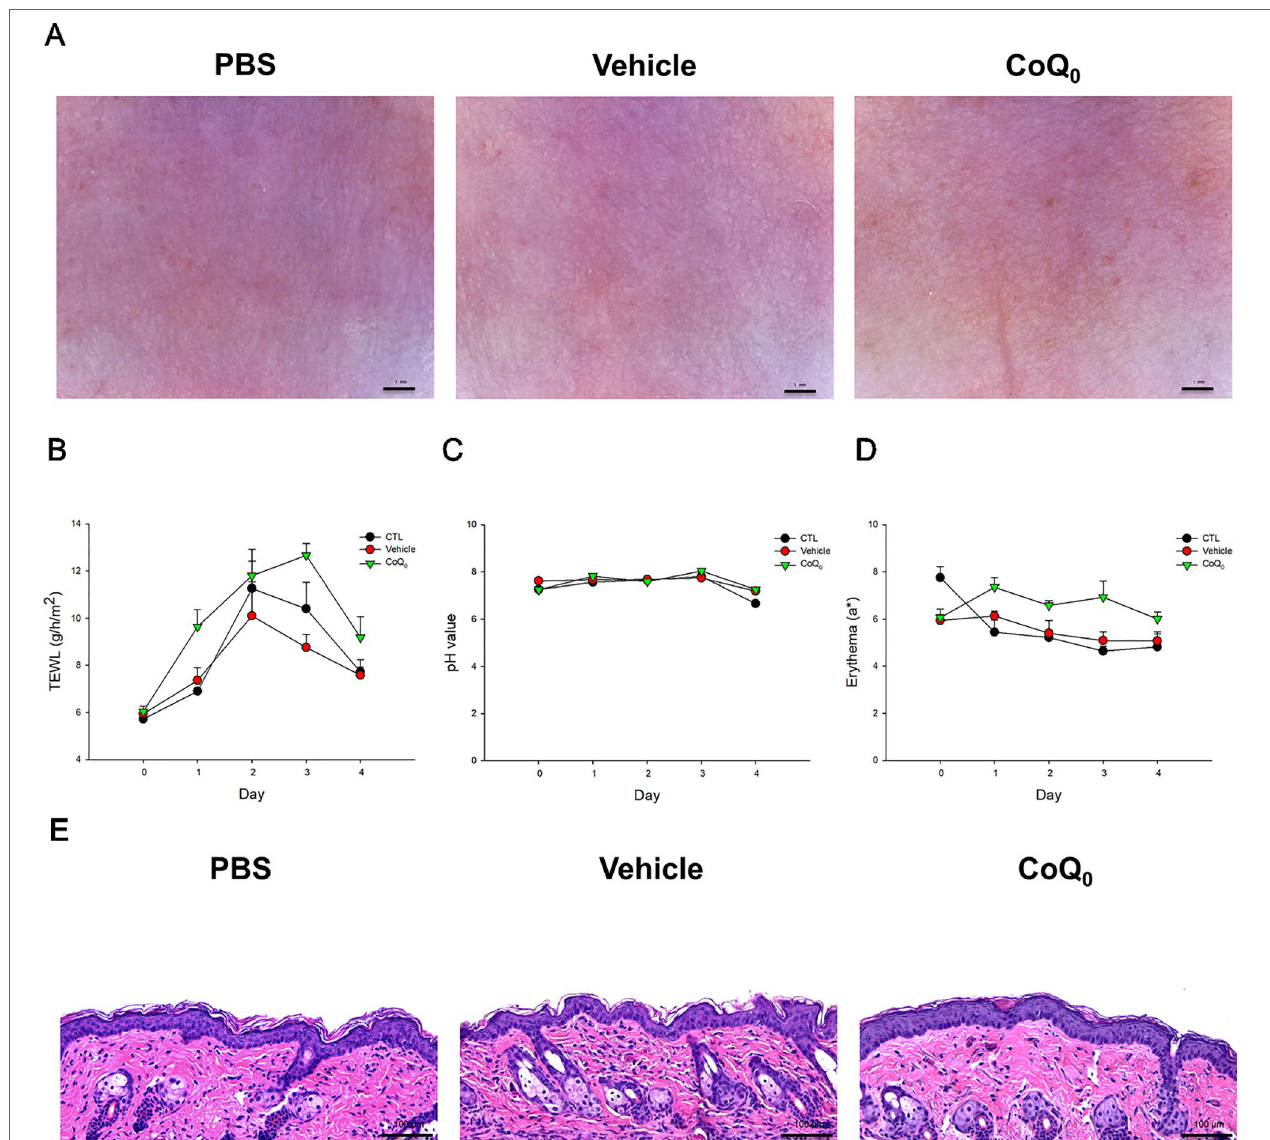
FIgURE 7 | In vivo skin tolerance examination after a 4-day application of topically applied CoQ 0 on mice. (A) The close-up imaging by handheld digital microscopy. (B) TEWL measurement. (C) Skin surface pH value. (D) Erythema measurement. (E) Skin sections represented by H&E staining. Each value represents the mean ± SEM (n =